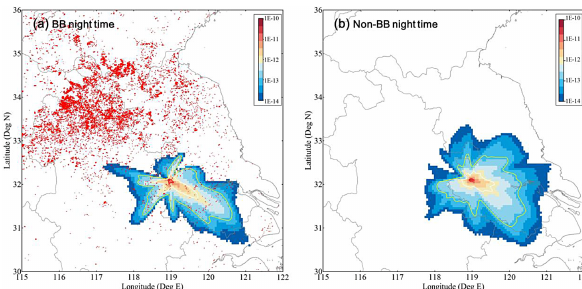
Figure 4. Map of 8h Lagrangian backward retroplume (100m foot- print layer) for (a) BB air masses (defined as K + >2µgm − 3 and K + /PM>2%) during nighttime, and (b) non-BB air masses (de- fined as K + <2µgm − 3 and K + /PM<2%) and active fire (pink dots) during 1–15 June 2012 (data obtained from FIRMS MODIS Fire